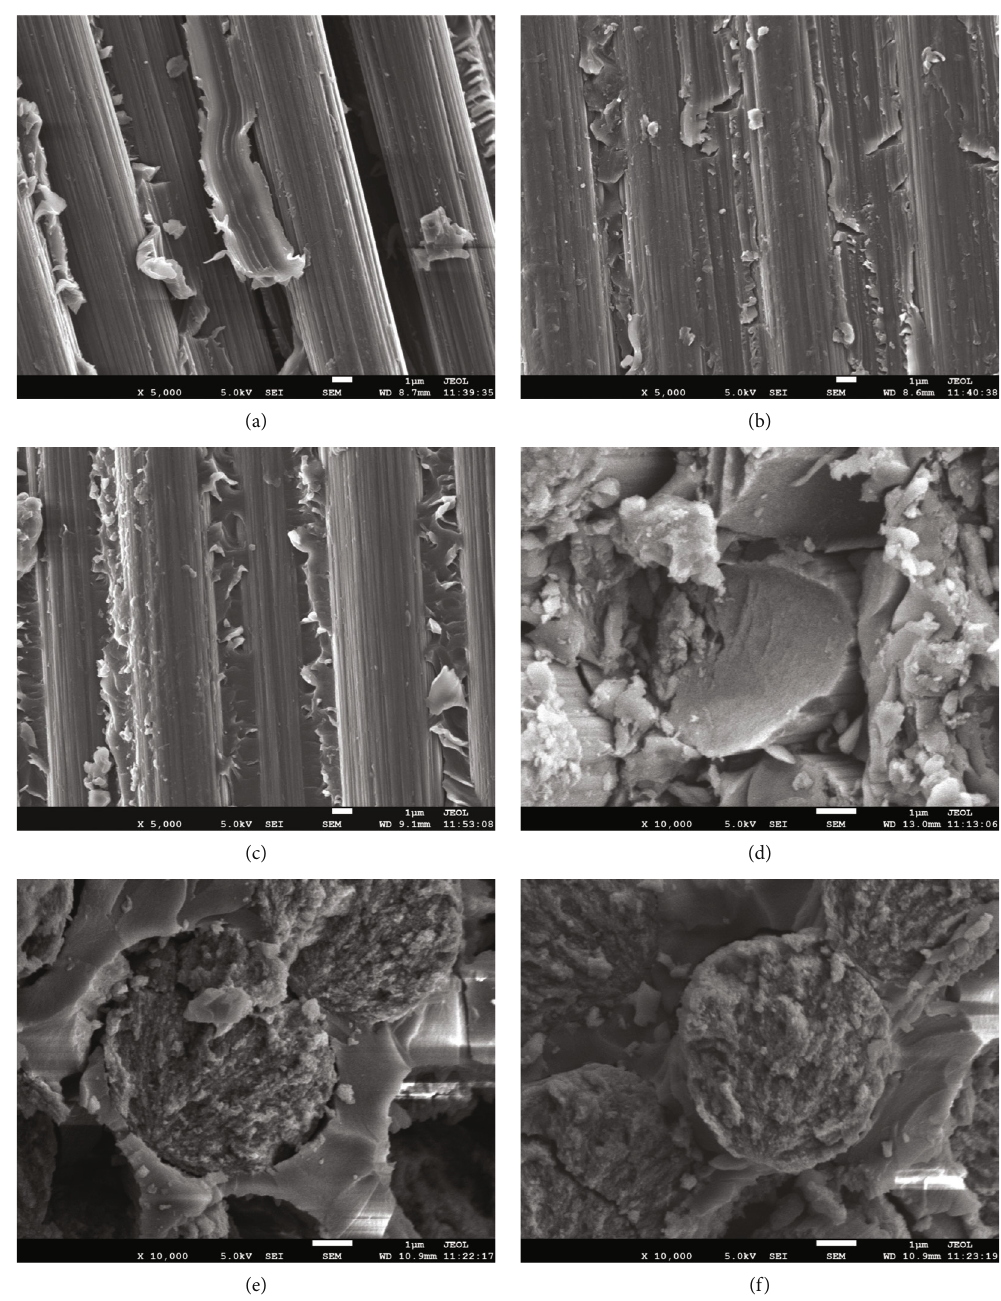
Figure 11: SEM images (a), (d): pure CFRP composite; (b), (e):0.05 wt.% GO-CFRP composite; (c), (f):0.1wt.% GO-CFRP